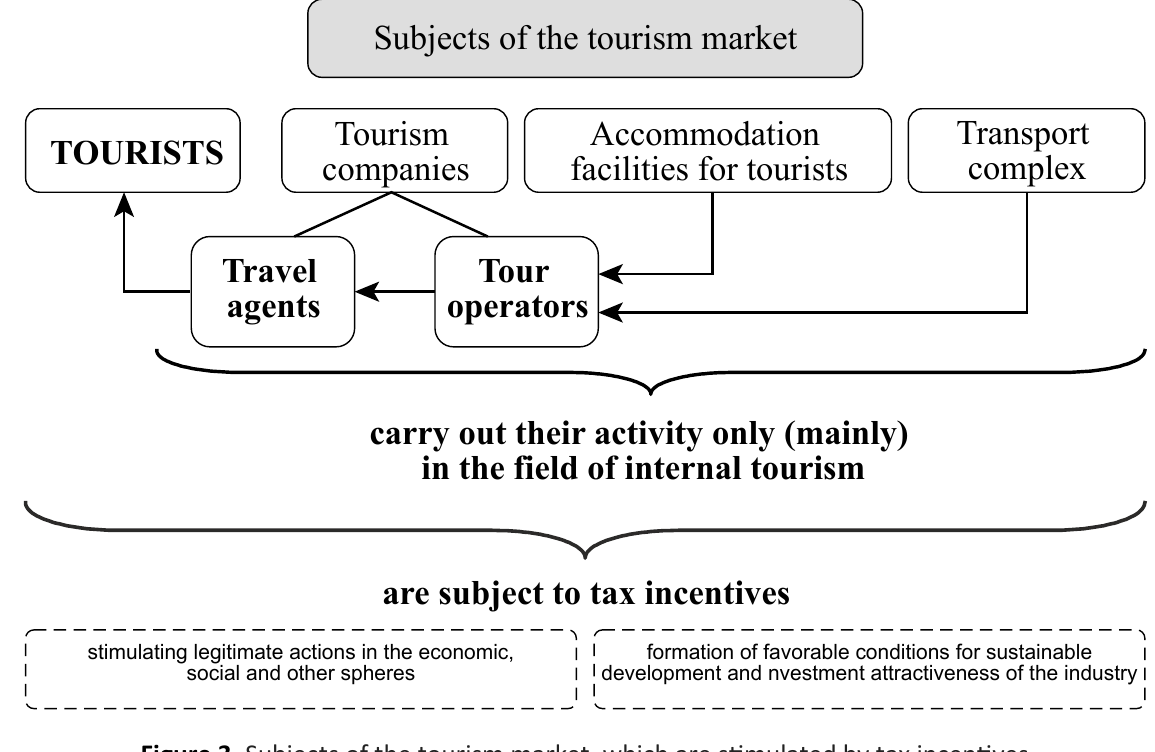
Figure 3. Subjects of the tourism market, which are stimulated by tax